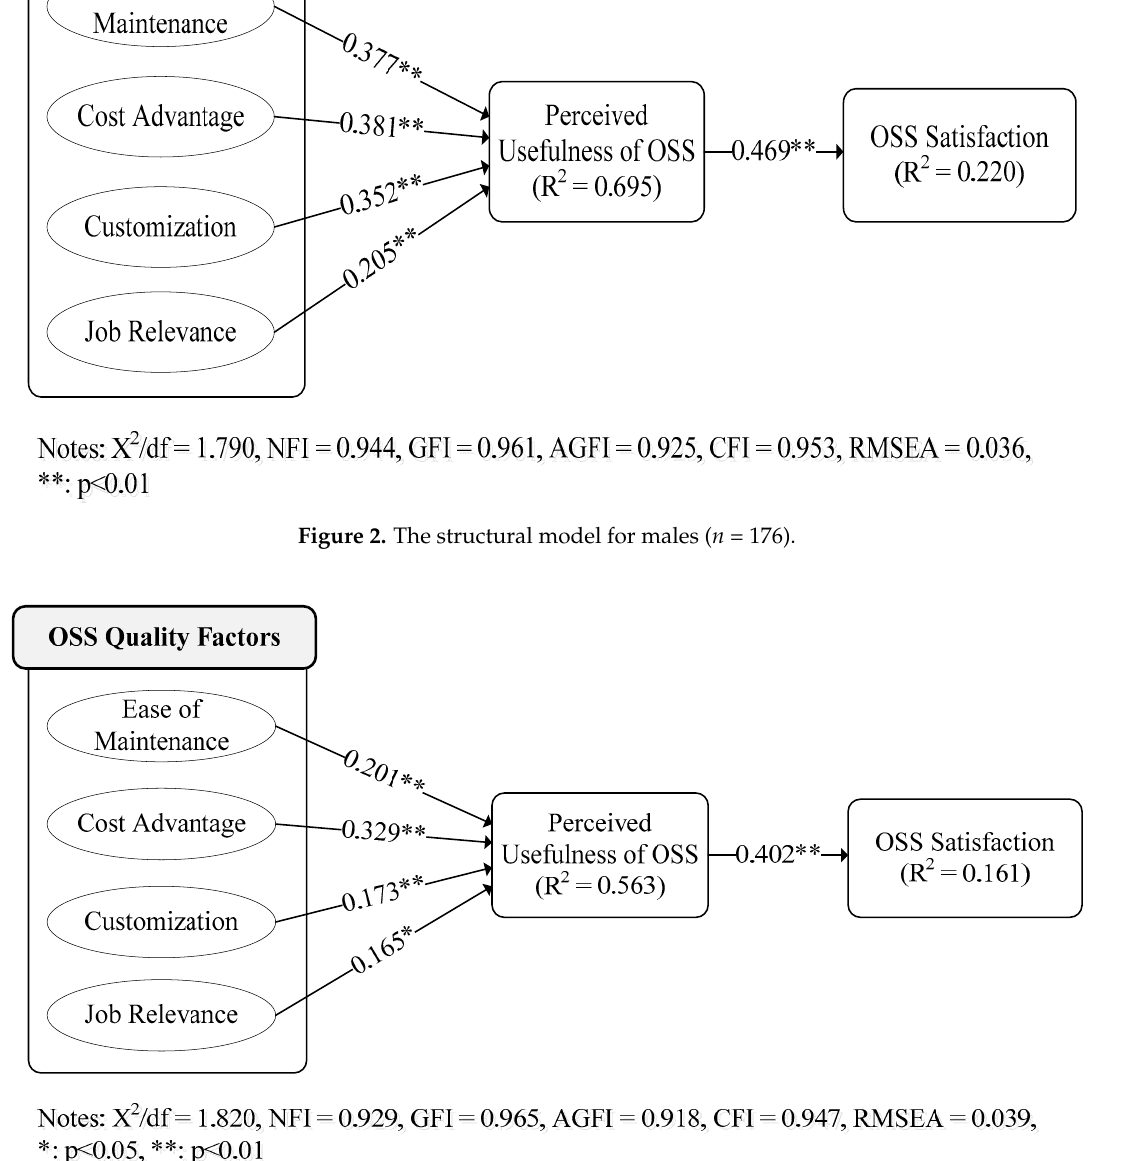
Figure 3. The structural model for females ( n = 152).